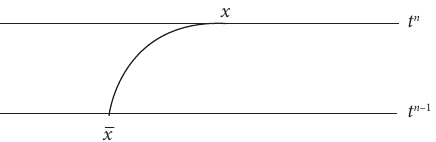
Figure 1: Te direction of